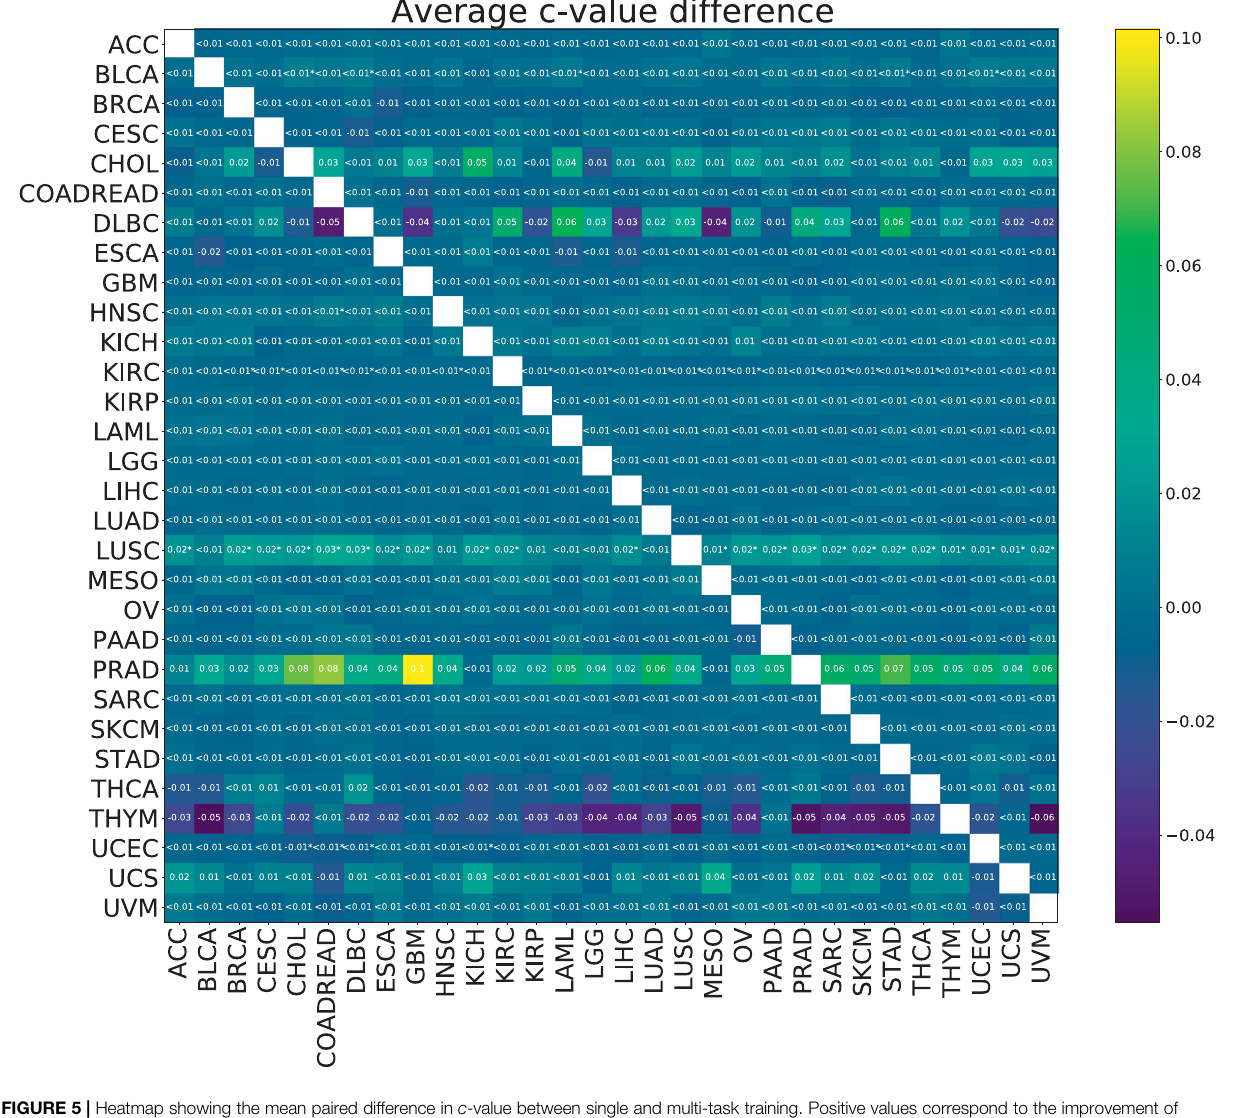
Frontiers in Genetics |